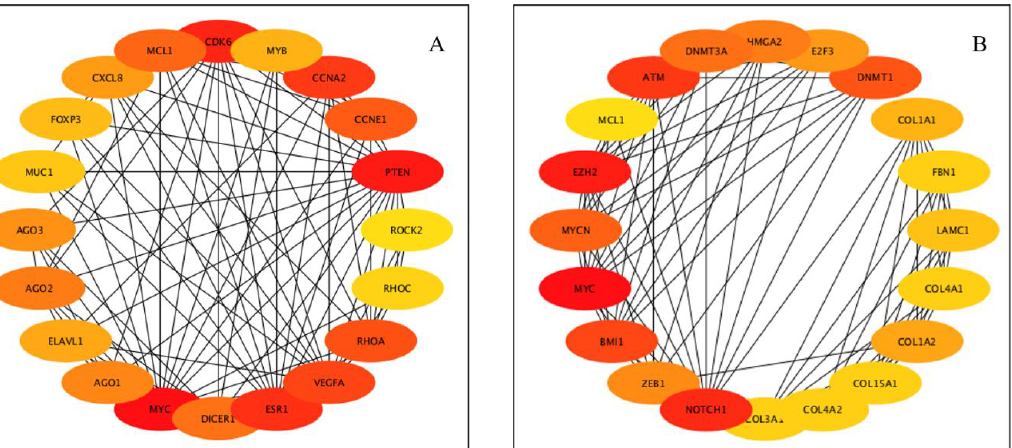
Figure 3. Interaction of hub genes of DE-miRNAs in the PPI network. ( A ) PPI network of top genes for highly upregulated DE-miRNAs; ( B ) PPI network of the top genes for highly downregulated DE-miRNAs. DE-miRNAs, differentially expressed microRNAs; PPI, protein-protein interaction; the PPI among hub genes for upregulated DE-miRNAs were greater compared with hub genes for down-regulated DE-miRNAs. Color red to yellow denotes high to low degree of expression. Black lines indicate interactions between genes.